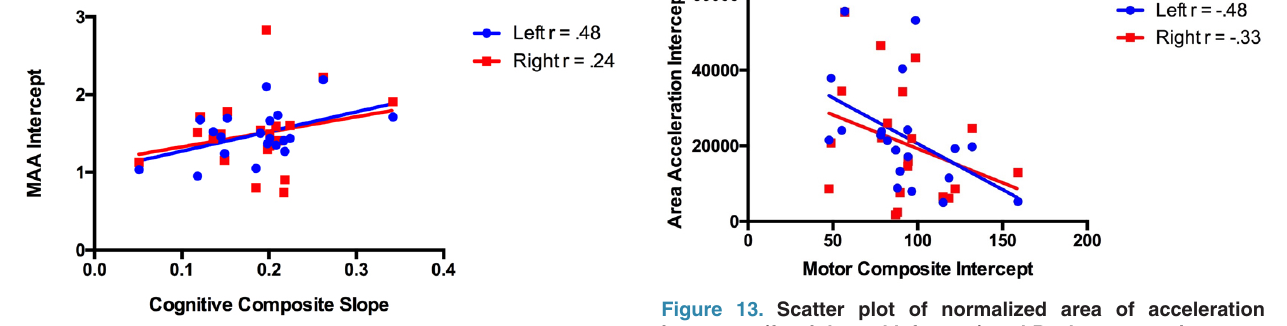
Figure 10. Scatter plot of mean average acceleration (MAA) intercepts (for right and left arms) and Bayley composite cognitive slopes of each infant.